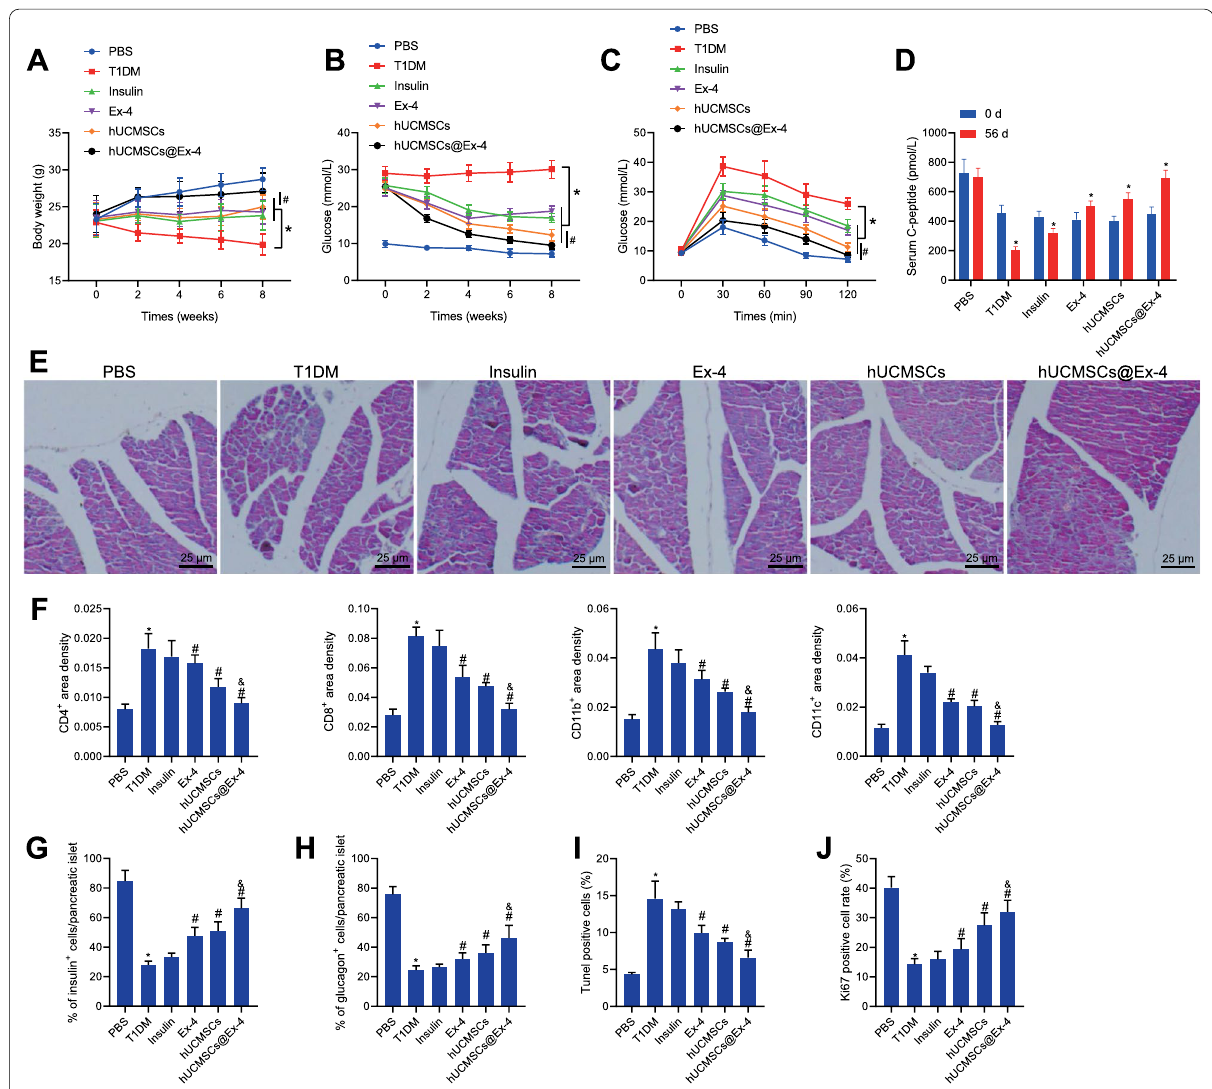
Fig. 2 hUCMSCs@Ex-4 reduces blood glucose levels and promotes the repair of islet tissue damage in T1DM mice. A Curve showing body weight changes of T1MD mice with different treatments. B Curve for blood glucose changes of T1MD mice with different treatment. C Blood glucose level in T1MD mice with different treatments, determined by OGTT. D, Fasting serum C peptide levels in T1MD mice with different treatments, analyzed by ELISA. E HE staining of islet morphology in T1MD mice with different treatments (400 ). F Immunohistochemical staining analysis of × the infiltration of immune cells in the pancreatic tissues of T1MD mice with different treatments. G Proportion of β-cells in the pancreatic tissues of T1MD mice with different treatments, analyzed by immunohistochemical staining for insulin. H Proportion of α-cells in the pancreatic tissues of T1MD mice with different treatments, analyzed by immunohistochemical staining for glucagon. I TUNEL-positive islet cells in the pancreatic tissues of T1MD mice with different treatments. J Ki67 immunohistochemical staining of islet cells in the pancreatic tissues of T1MD mice with different treatments. In panels, * p < 0.05 vs. T1DM mice. # p < 0.05 vs. T1DM mice treated with hUCMSCs@Ex-4 vs. T1DM mice treated with hUCMSCs. In F – J , * p < 0.05 vs. PBS-treated mice. # p < 0.05 vs. T1DM mice. & p < 0.05 vs. T1DM mice treated with